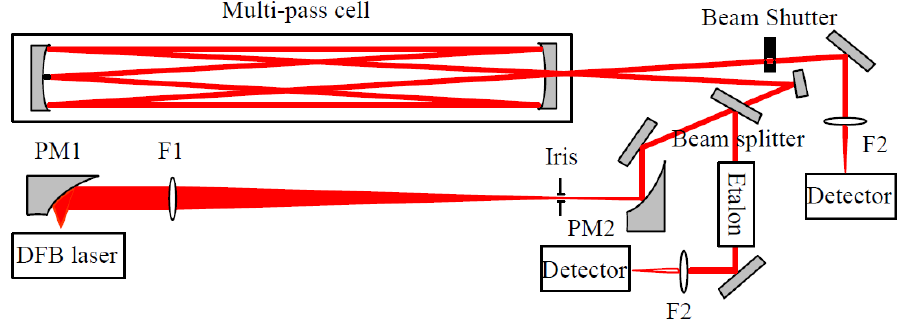
Figure 1. Optical layout. PM1 and PM2: parabolic mirrors with effective focal length of 25 mm and 50 mm, respectively; F1 and F2: lenses of focal length of 200 mm and 50 mm,